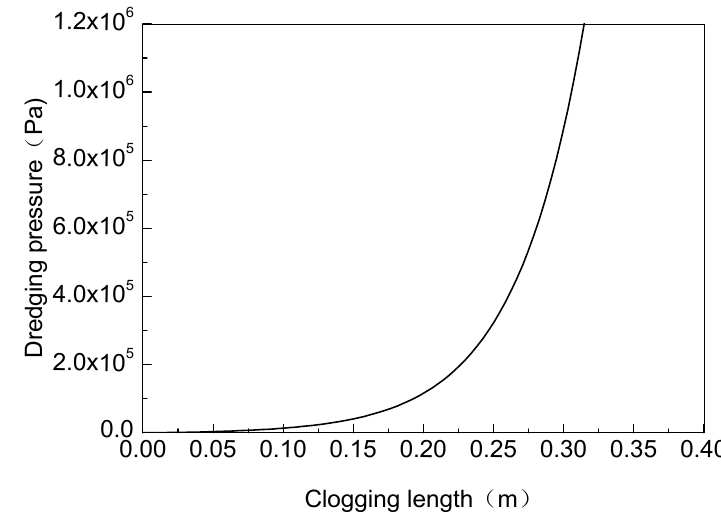
Figure 10. The p – L characteristic curve under the parameters of the drilling technology.